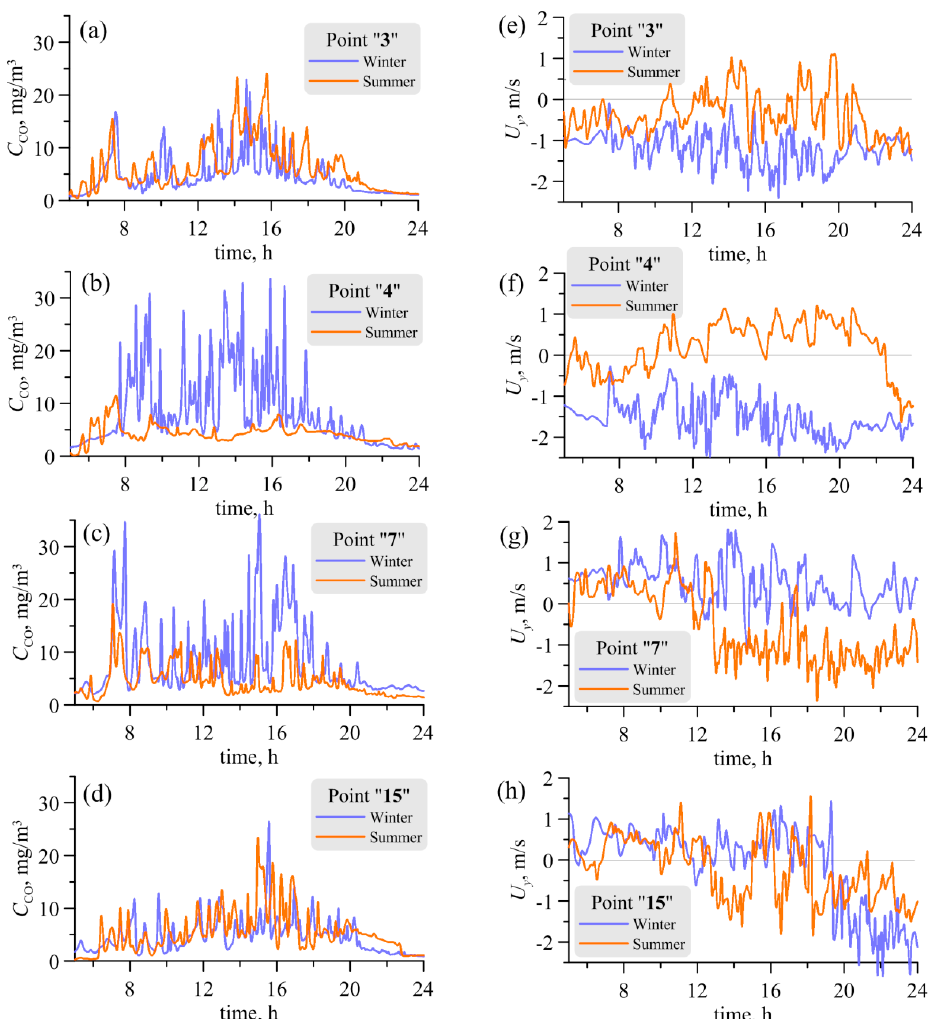
Figure 12. Modeled fields temporal evolution plots near the ground (10 m altitude) for several points (shown in Figure 1). ( a – d ) Concentration; ( e – h ) Horizontal velocity (river-normal component). At point “15” located on the other river bank, the flow has the same morning behavior as for point “3” (except for the sign of velocity). But after 2000 LT the winter flow experiences the change in direction, presumably reflecting the change in local circulation shape or the local fluctuation of the updraft position.